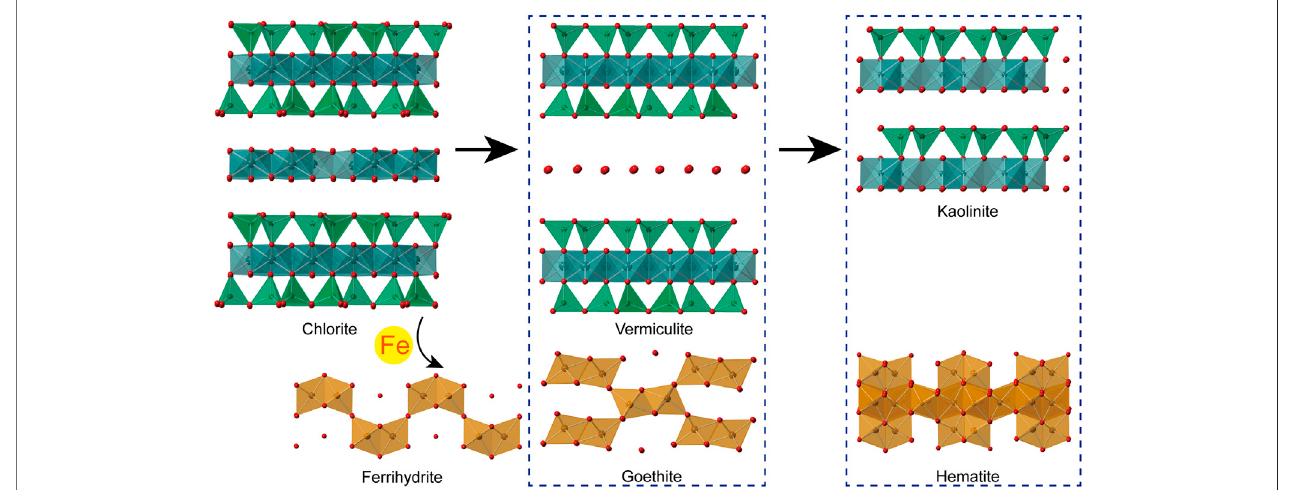
FIGURE 9 | The weathering process of chlorite (modi fi ed after Aspandiar and Eggleton, 2002a).